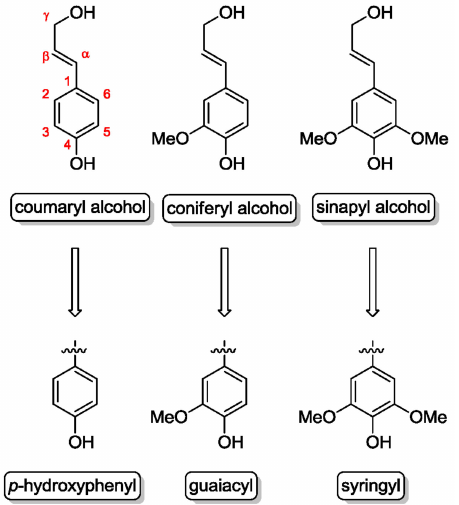
Figure 3. Structure of the three monolignol precursors and their corresponding fragments in the macromolecules.